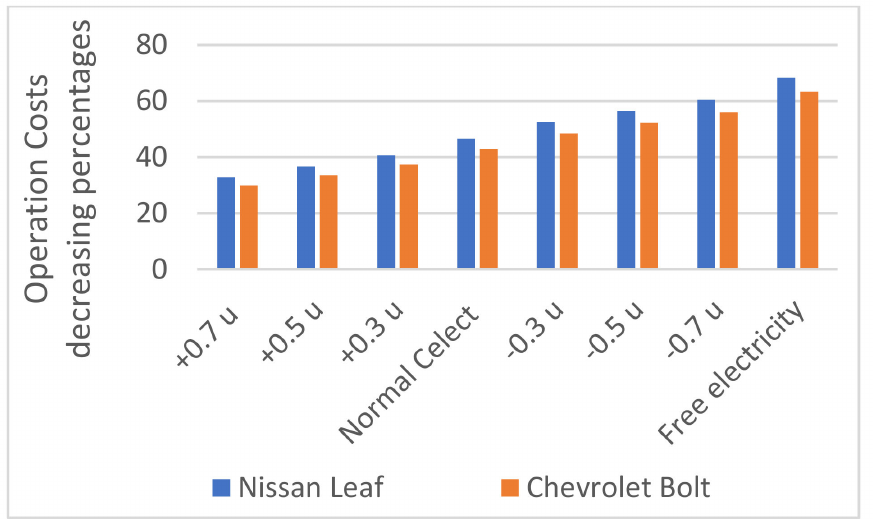
Figure 10. Decrease in the operation cost percentage with electricity variations compared with the Chevrolet